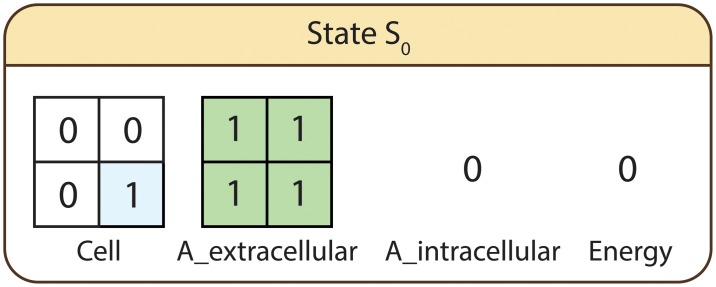
Initial state of the system.Cell and A_extracellular are the spatial state variables representing the position of the cell, respectively distribution of nutrient A in the environment. A_intracellular and Energy represent the intracellular availability of nutrient A, respectively energy.